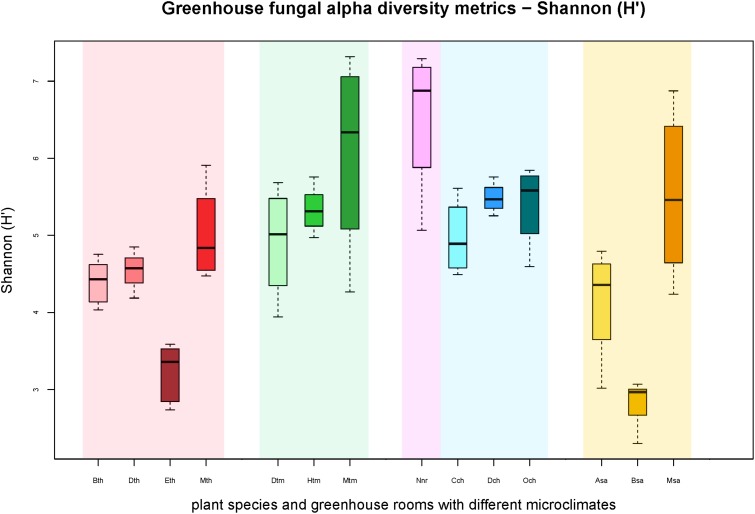
Boxplots of the Shannon diversity metric (H′) for individual plant species grouped according to respective greenhouse rooms (indicated by background colors: red – tropical house, green – warm temperate house, magenta – nursery, blue – cold temperate house, yellow – succulent house). Sample groups were abbreviated as: Bth, Aechmea eurycorymbus; Dth, Dracaena marginata; Eth, Epipremnum aureum; Mth, Musa paradisiaca; Dtm, Dracaena fragrans; Htm, Howea forsteriana; Mtm, Malvaviscus penduliflorus; Nnr, Nephrolepis cordifolia from a nursery room; Cch, Chlorophytum comosum; Dch, Dracaena draco; Och, Olea europaea; Asa, Aloe arborescens; Bsa, Beaucarnea recurvata; Msa, Musa acuminata.